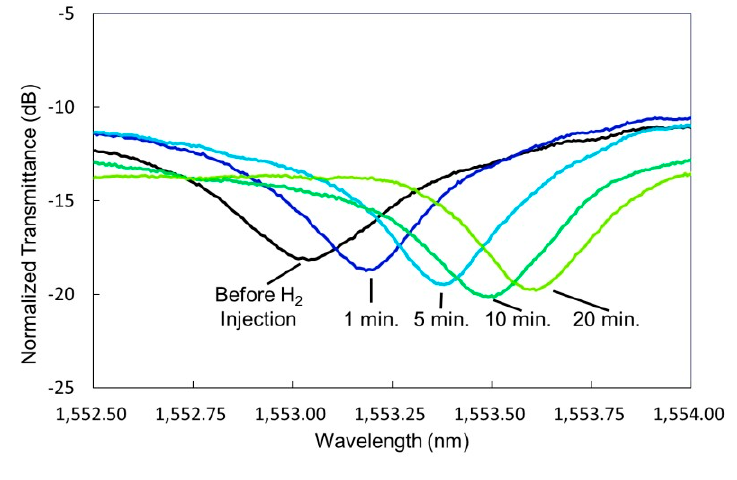
Figure 3. The sensor response to pure hydrogen.